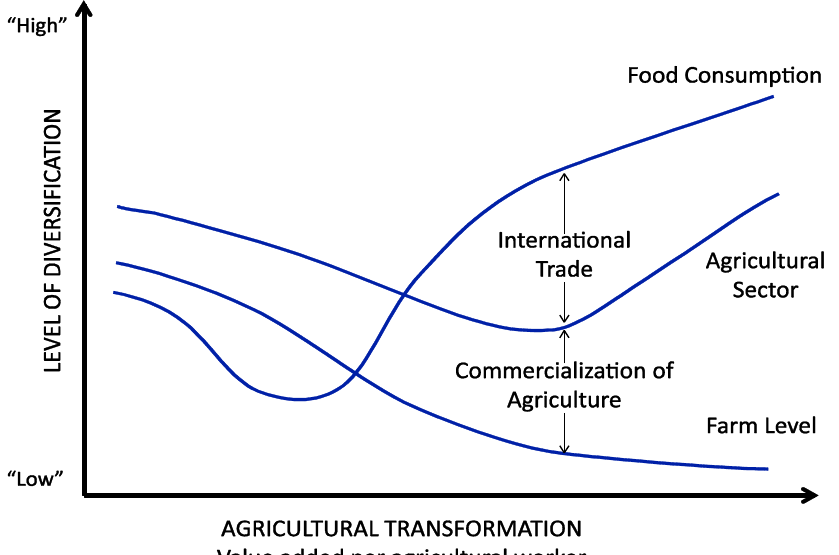
Figure 1. The relationship between diversification and agricultural